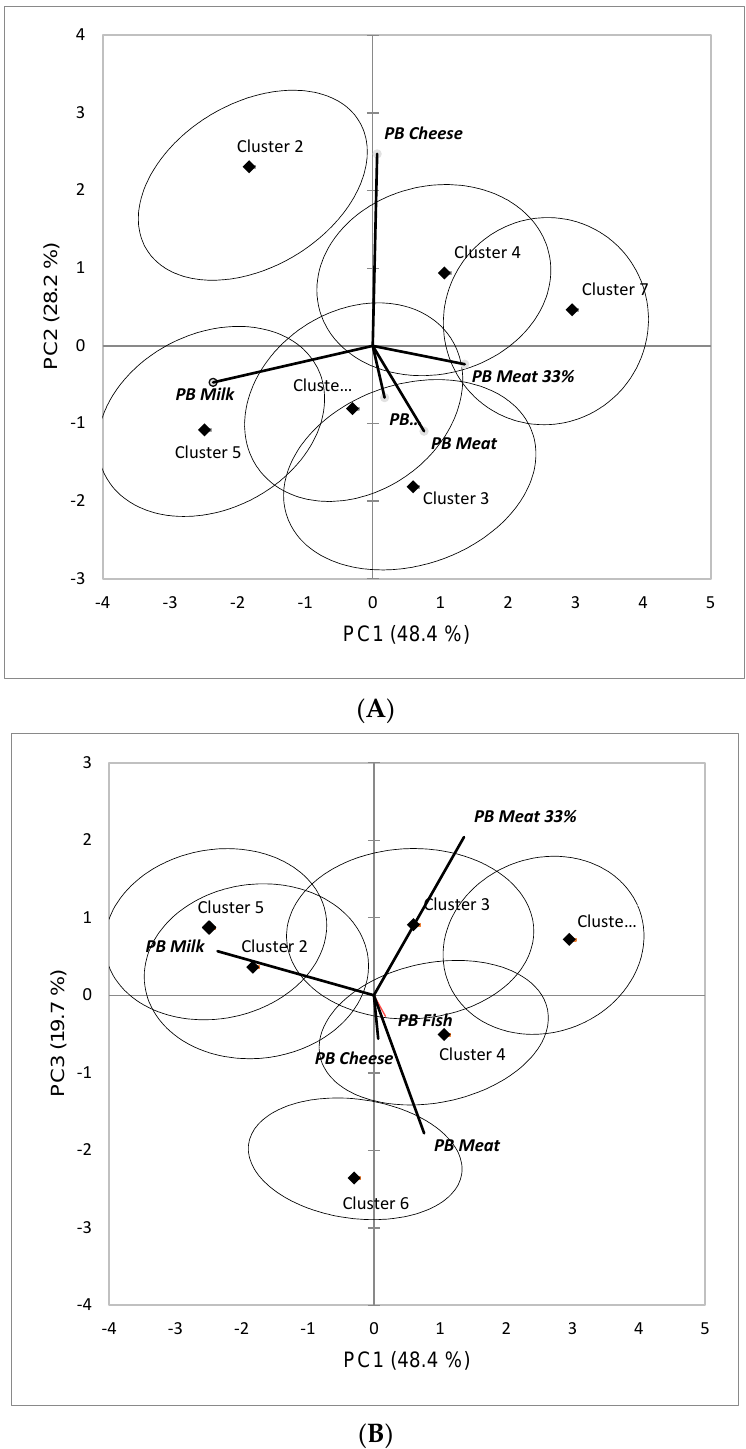
Figure 4. Two-dimensional biplots following Principal Components Analysis of mean willingness to consume (WTC) ratings for PB food categories in the six PB category discriminating clusters (Cluster 2 to Cluster 7). Confidence ellipses (95%) around average cluster positions were obtained by bootstrapping. ( A ) PC1 vs. PC2; ( B ) PC1 vs. PC3. ( A , B ), PB food categories are shown in bold and italic font.